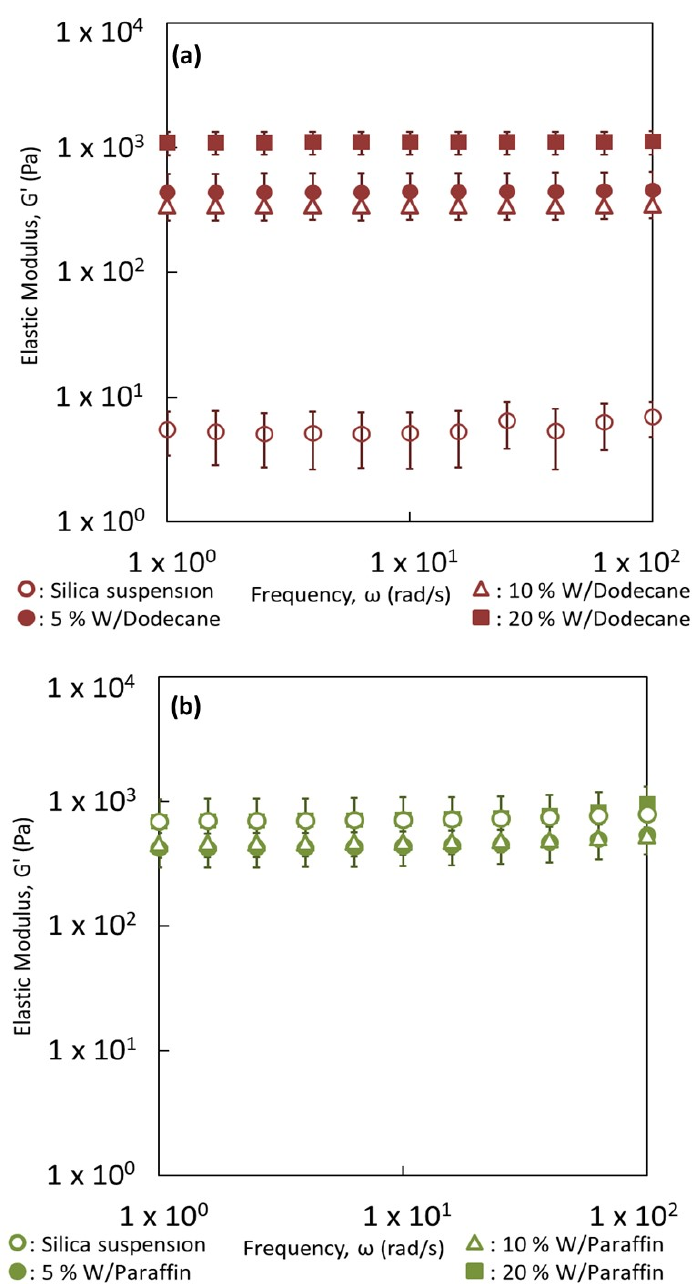
Figure 11. Comparison of the rheological behavior of reverse W/O emulsions with various dispersed phase fractions stabilized with 4 wt.% of silica particles and a suspension of silica particles (4 wt.%) dispersed in ( a ) dodecane and ( b ) paraffin. Dispersed phase fractions of 5%, 10% and 20% are used.